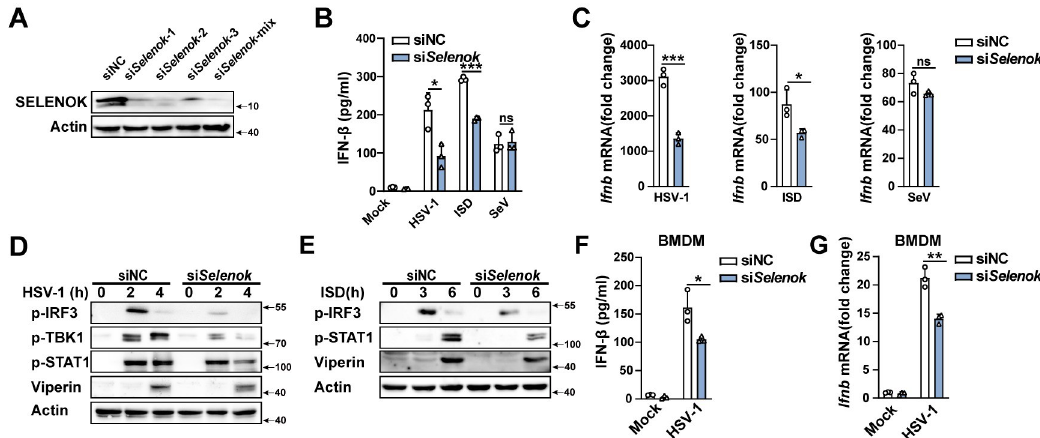
Fig 2. Selenok knockdown specifically inhibits cGAS-STING signaling. (A) Immunoblot analysis of SELENOK expression in PMs transfected with siRNA. (B) ELISA analysis of IFN- β secretion in PMs stimulated with HSV-1, ISD, and SeV after transfection with siRNA. (C) Real-time PCR analysis of Ifnb mRNA levels in PMs stimulated with HSV-1, ISD, and SeV after transfection with siRNA. (D) Immunoblot analysis of p-IRF3, p-TBK1, p-STAT1, and Viperin expression in PMs stimulated with HSV-1 after transfection with siRNA. (E) Immunoblot analysis of p-IRF3, p-STAT1, and Viperin expression in PMs stimulated with ISD after transfection with siRNA. (F) ELISA analysis of IFN- β secretion in BMDMs stimulated with HSV-1. (G) Real-time PCR analysis of Ifnb mRNA levels in BMDMs stimulated with HSV-1. Statistical significance was determined by unpaired two- sided multiple Student’s t-tests in B-C and F-G. Data represent mean ± standard deviation (SD) or one representative image from three independent experiments. ns: not significant, * : P < 0.05, ** : P < 0.05, *** P: < 0.001. siNC, control siRNA; si Selenok -1,2,3, and mix (S1 Table).